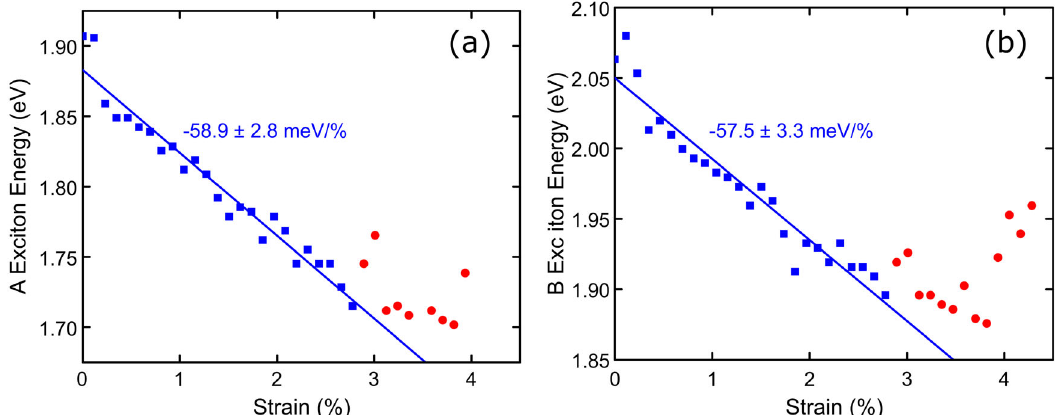
Fig. 4 Maximum achievable strain. a , b A and B exciton energies, respectively, of a single-layer MoS 2 fl ake at different uniaxial strain values after adamantane plasma polymer encapsulation. The straining test has been carried out until the failure of the device. The blue squares and red dots correspond to the datapoints acquired before and after the fl ake starts to slip,